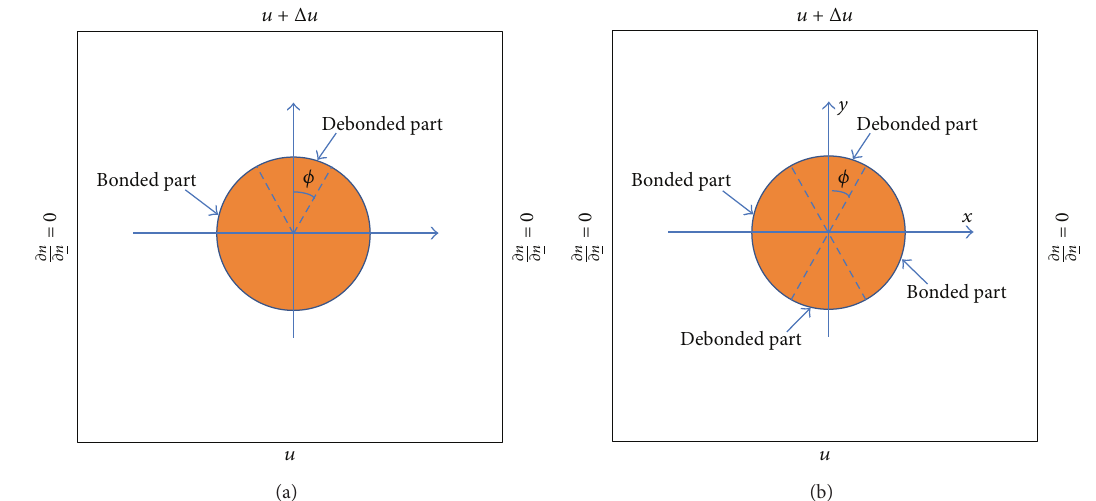
Figure 2: (a) Single partial debonding of circular inclusion. (b) Double partial debonding of circular